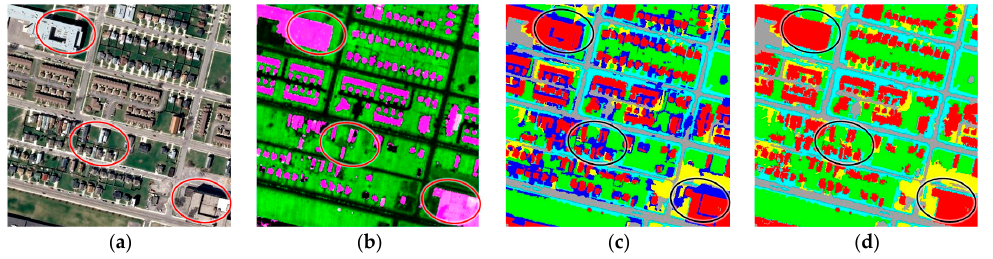
Figure 20. Fusion for shadow areas of high-resolution image: ( a ) high-resolution image, ( b ) LiDAR data, ( c ) joint classification map using LiDAR data and high-resolution image before object-based post-classification fusion, and ( d ) classification map after object-based post-classification fusion.